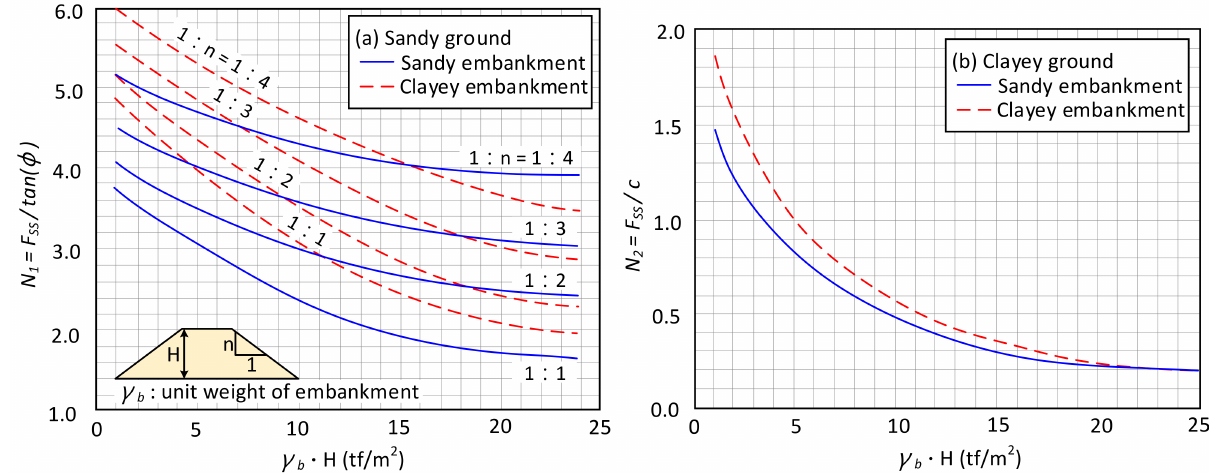
Figure 5. Soil-type-dependent coefficients. ( a ) sandy ground; ( b ) clayey ground. After the calculation of the static factor of safety ( F S 0 ), the dynamic factor of safety ( F Sd ) was calculated next. The dynamic factor of safety was calculated by considering two scenarios of earthquake-induced inertial force F Sd ( k h ) and soil liquefaction F Sd ( ∆ u ) independently. The calculation of F Sd ( k h ) is shown as follows.